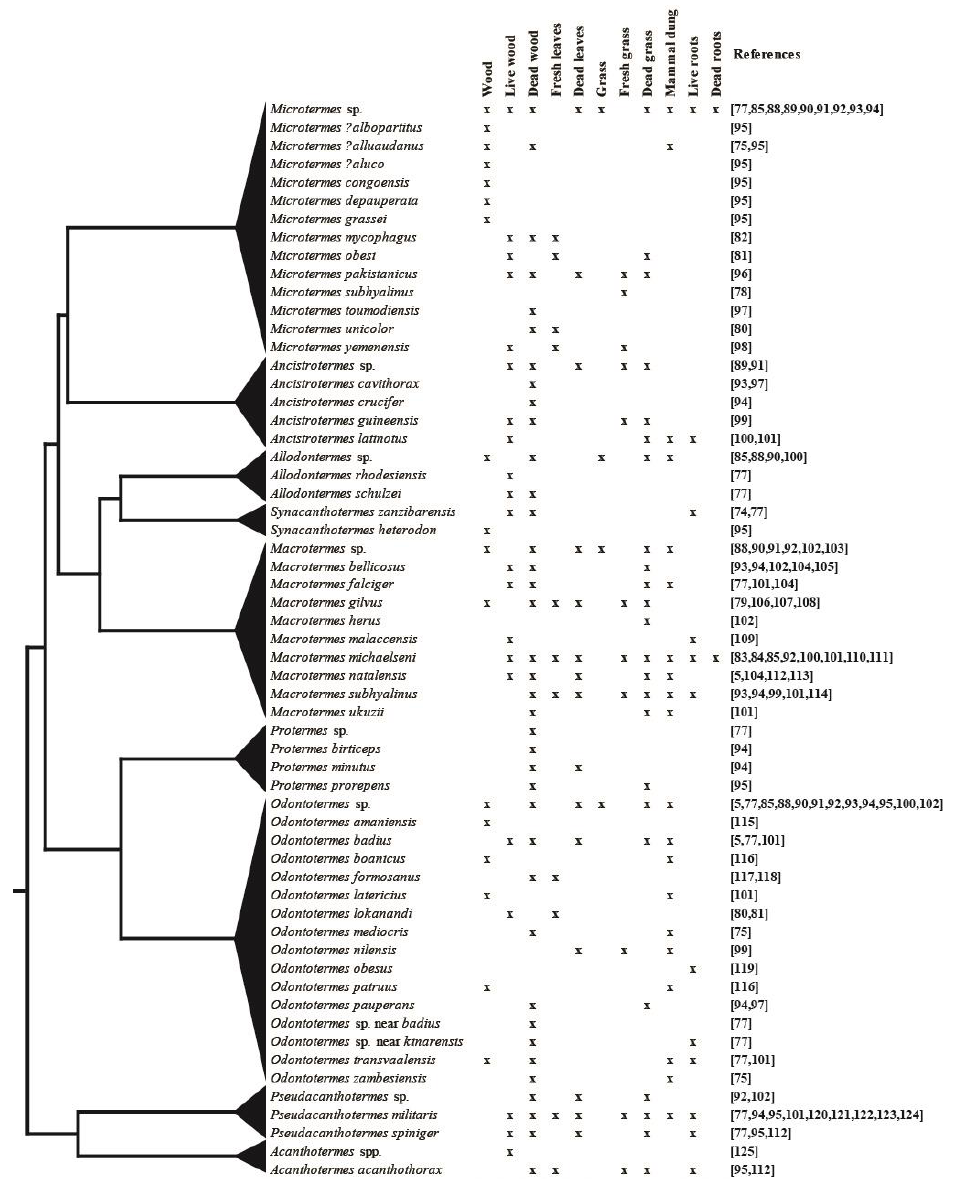
Figure 2. Forage substrate use by fungus-growing termites found in the literature (for a full list of all references and their reported findings, see Table S1 [5,74,75,77–85,88–125]) mapped on a schematic phylogeny of the subfamily [35]. Species given the same species name or labelled sp. or spp. in the original reports were grouped for clarity. The last columns “Wood” and “Grass” give cases where authors only mention forage substrate but not whether the plant material was alive or dead. The annotations “?” or “near” were not explained in the original reports, and the species were, therefore, treated as unique